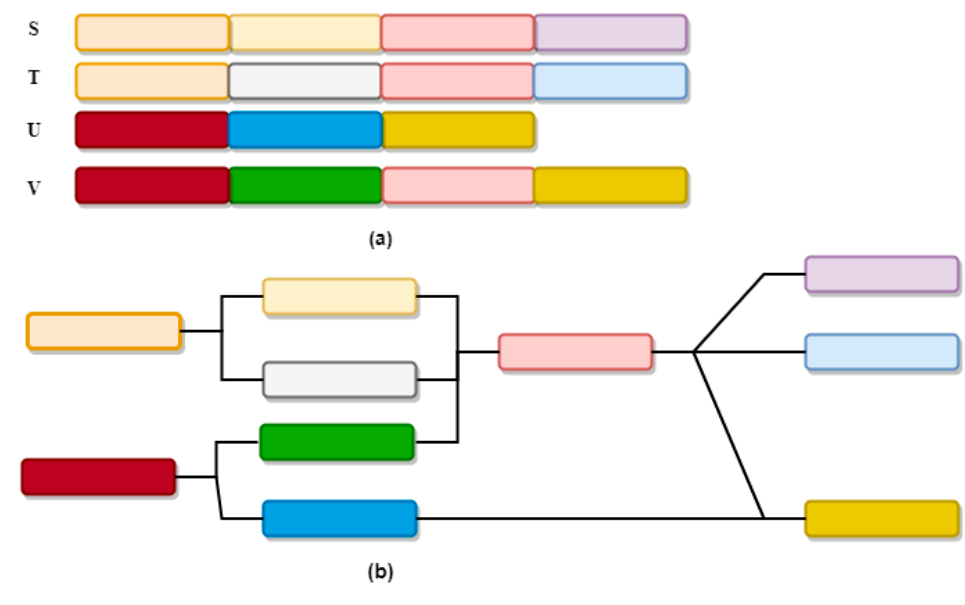
Figure 2. ( a ) tetraploid genome ( b ) assembly graph.